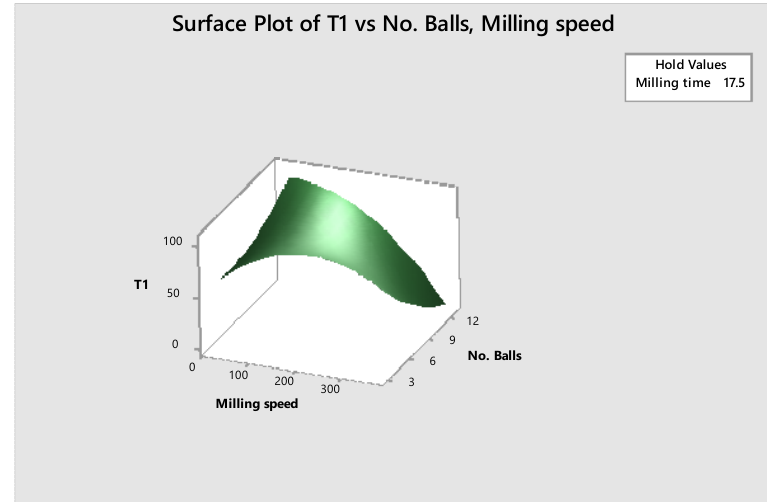
Figure 10. T1 vs. milling speed vs. no. of balls.